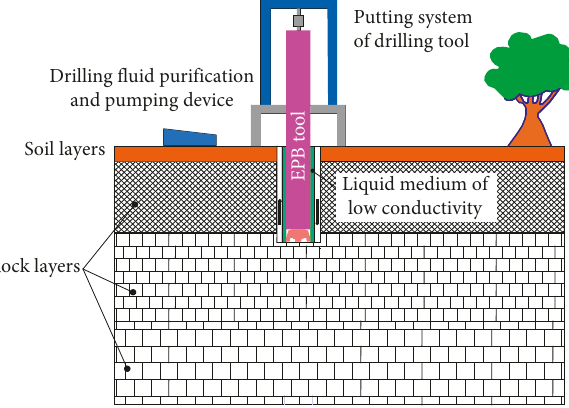
Figure 2: Structural sketch of an EPB rock-breaking